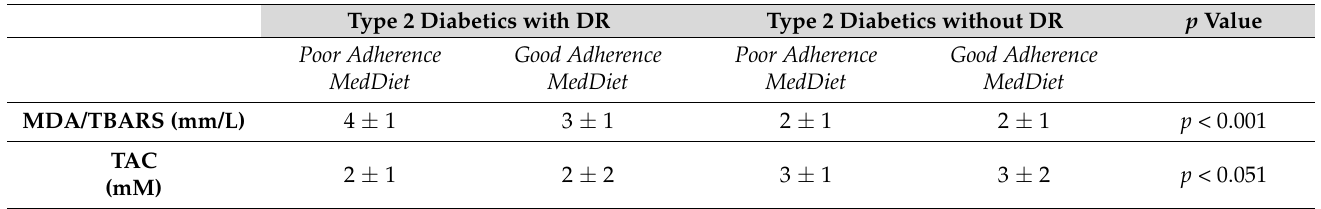
Table 2. Comparative data on plasmatic redox biomarkers according to the adherence to MedDiet. Type 2 Diabetics with